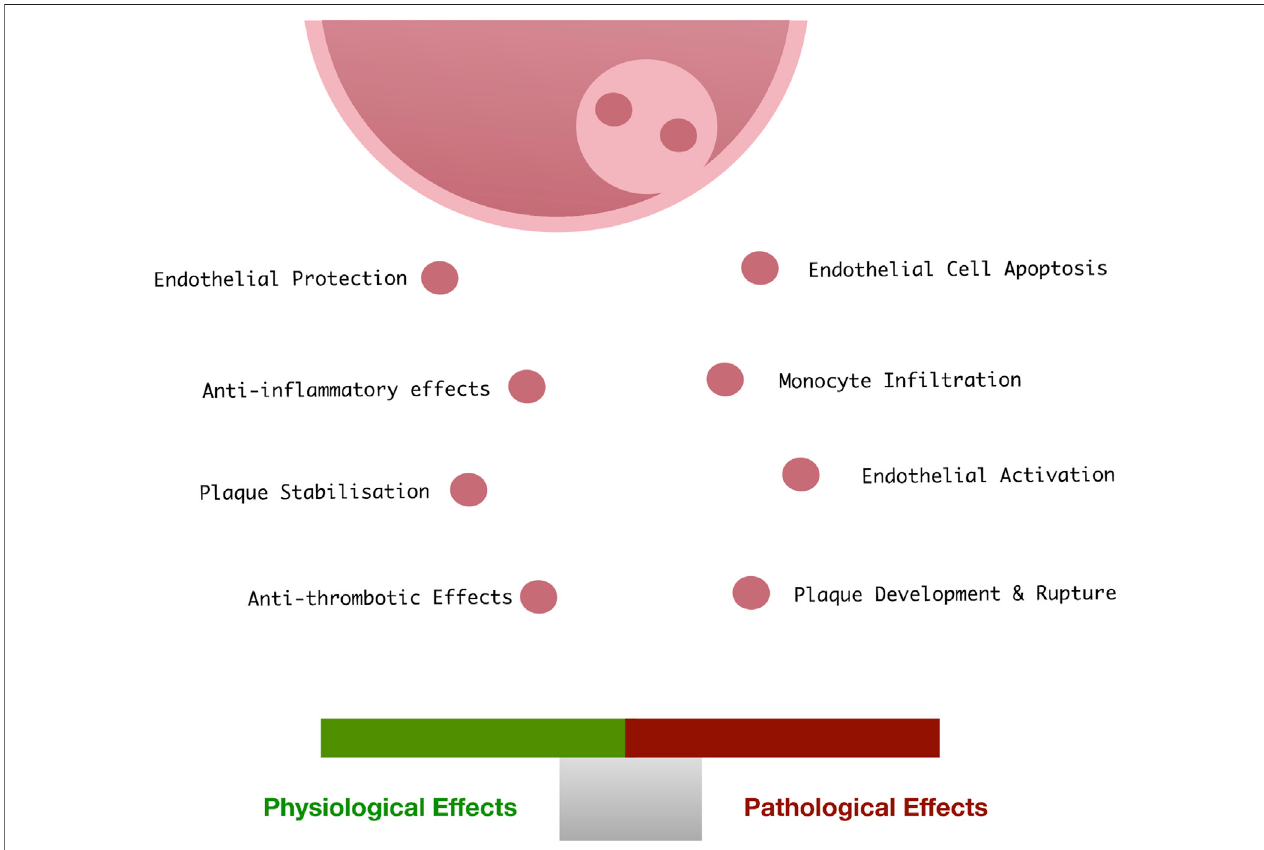
FIGURE 4 | Endothelial exosomes in vascular health and disease: Under physiological conditions, endothelial cells release exosomes at low concentrations which facilitatetheprotectionandvascularhomeostasis.Whenexposedtopathologicalvascularstimuli,thecontentoftheseexosomeschanges,resultinginalossofvascular homeostasis, apoptosis, monocyte in fi ltration, and subsequent facilitation of the development of CVD.